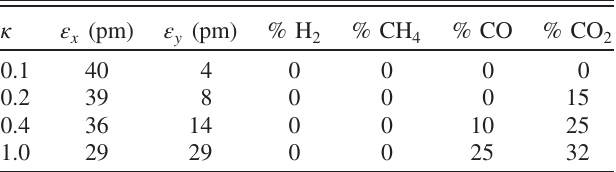
TABLE II. Percent of lattice that will trap ions in 324-bunch mode, for different emittance